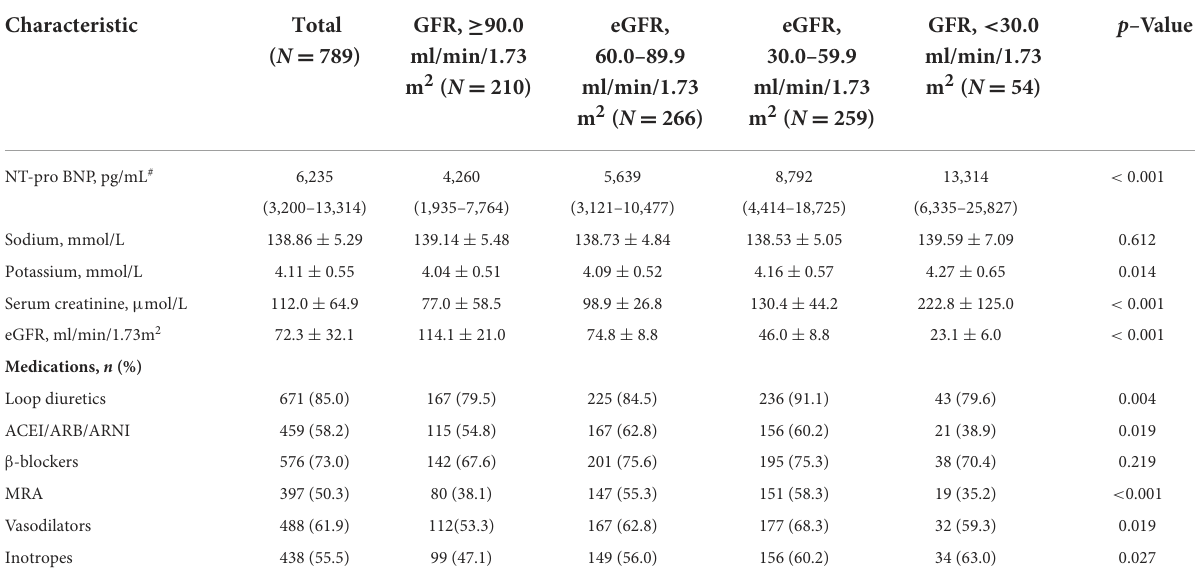
Adverse events occurred in 74 patients (9.3%), which was no significant differences among the eGFR groups ( p = 0.85). Among those, 47 patients suffered hypotension (5.9%), and new onset arrhythmias, including atrial fibrillation or ventricular tachycardia, occurred in 15 patients (1.9%). Other